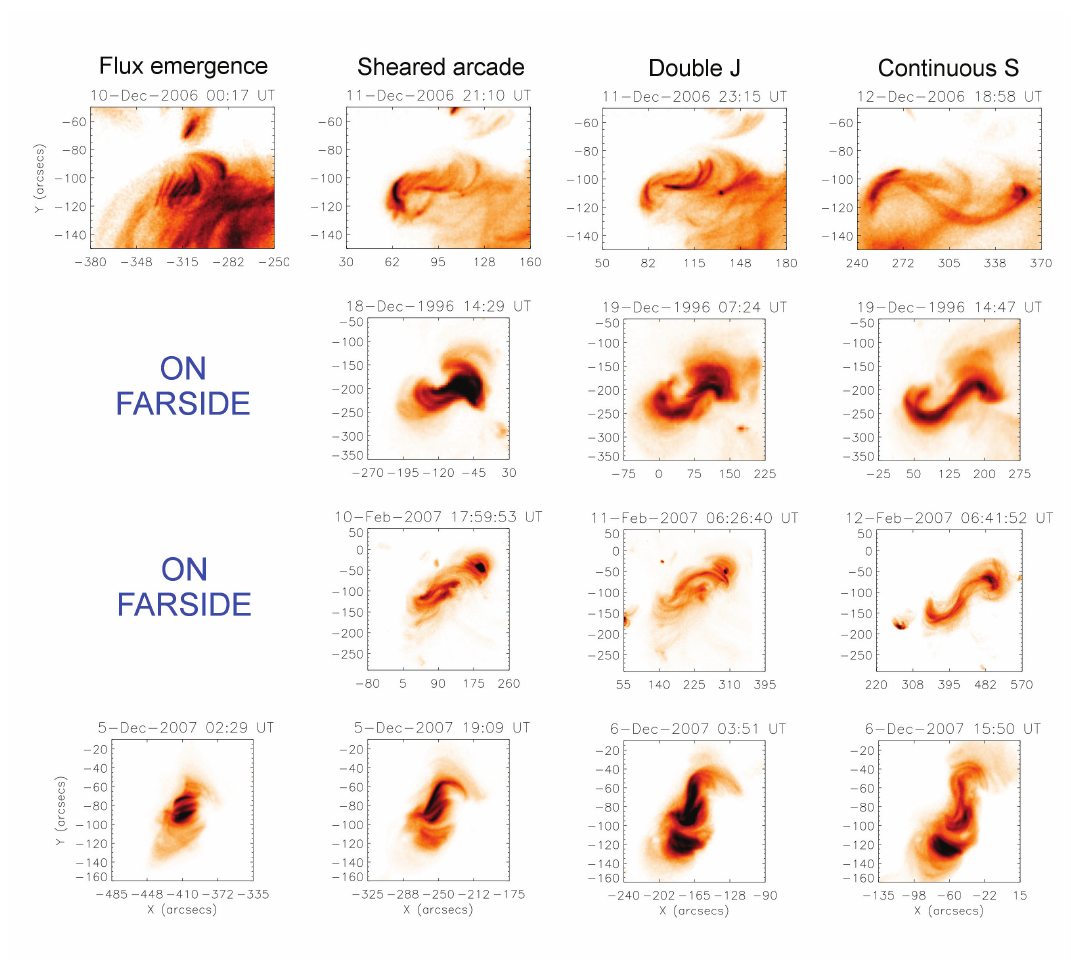
Figure 15: Sigmoidal active region structures formed in the decay phase show an evolution from acrcade (first column) to sheared arcade (second column) to double-J (third column) and then to a continuous S shape (fourth column). Four active regions are shown here NOAA AR 10930 (top row), NOAA AR 8005, an un-numbered region from February 2007 (second row from bottom) and NOAA AR 10977 (bottom row). Image reproduced with permission from Green and Kliem (2014), copyright by